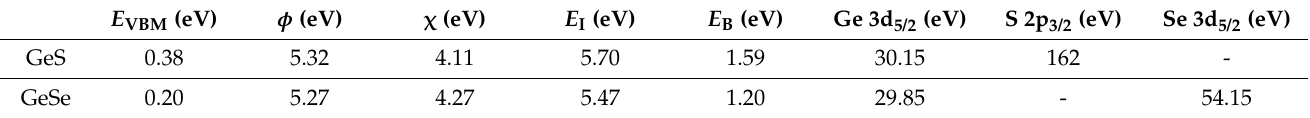
Table 1. Basic electronic properties and main core level line positions for GeS and GeSe.